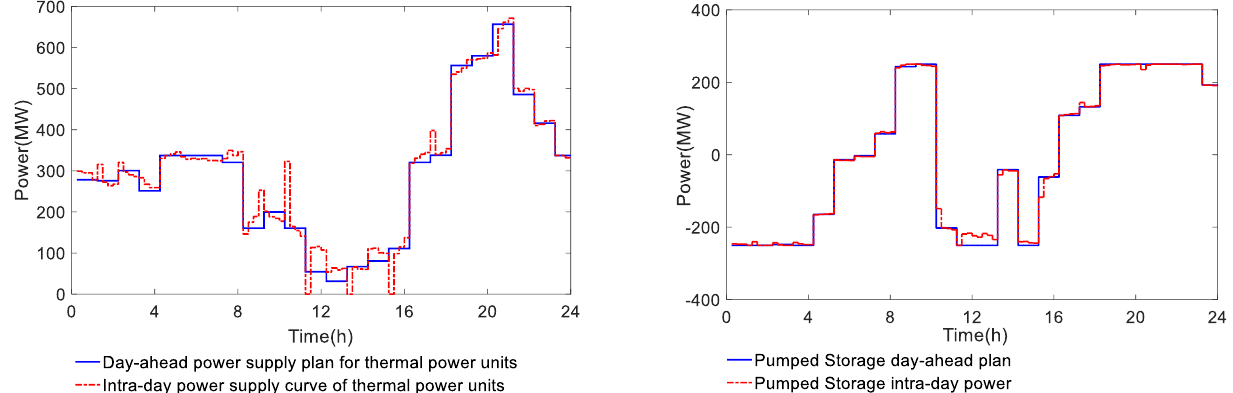
Figure 9. Comparison between current plan and actual output of thermal power unit and pumped storage unit.